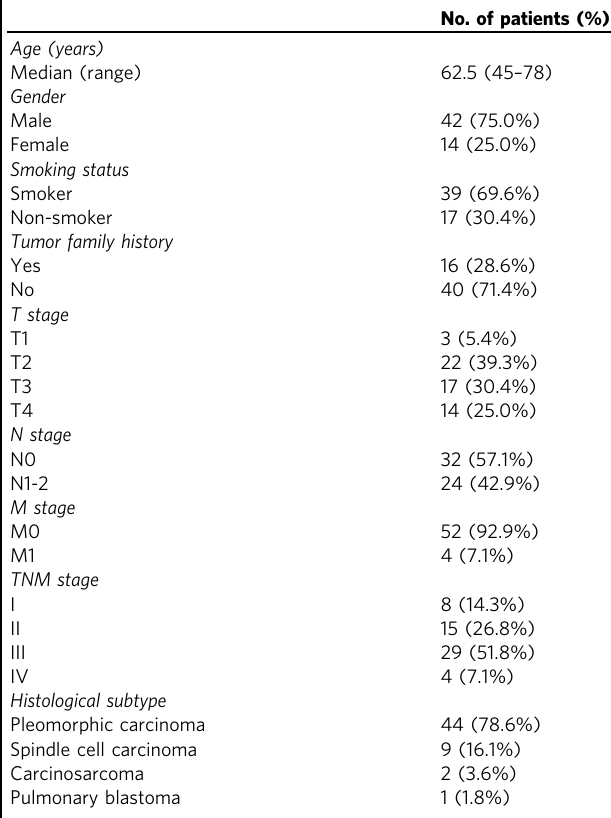
Table 1 Clinicopathological characteristics of the study